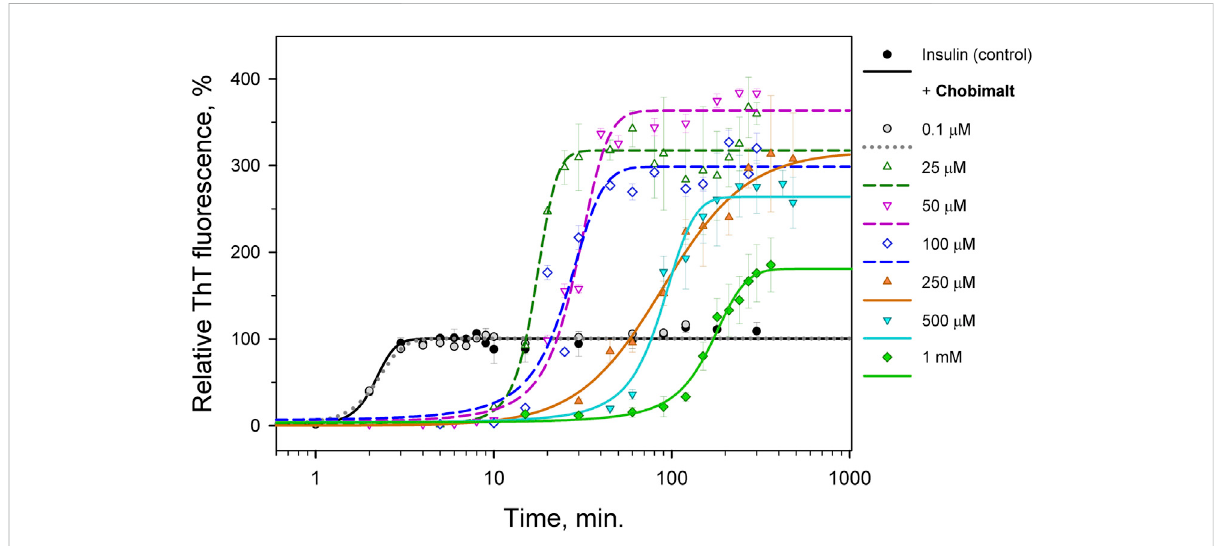
FIGURE 3 Time-dependence of insulin fi brillization in the presence of Chobimalt evaluated by ThT assay. Chobimalt has been added to freshly prepared insulin solution and samples were exposed to fi brillization